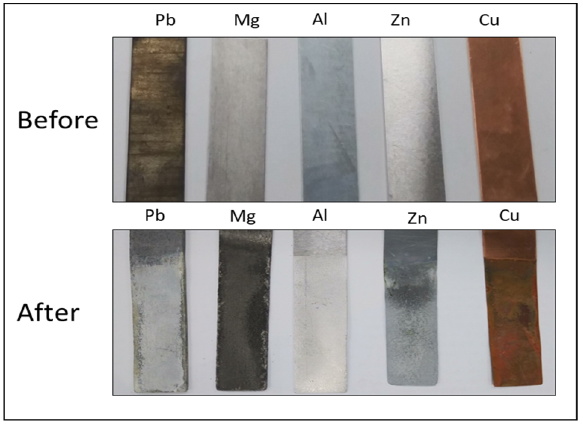
Figure 6. The anodes before and after the experiment at 30 V are compared.